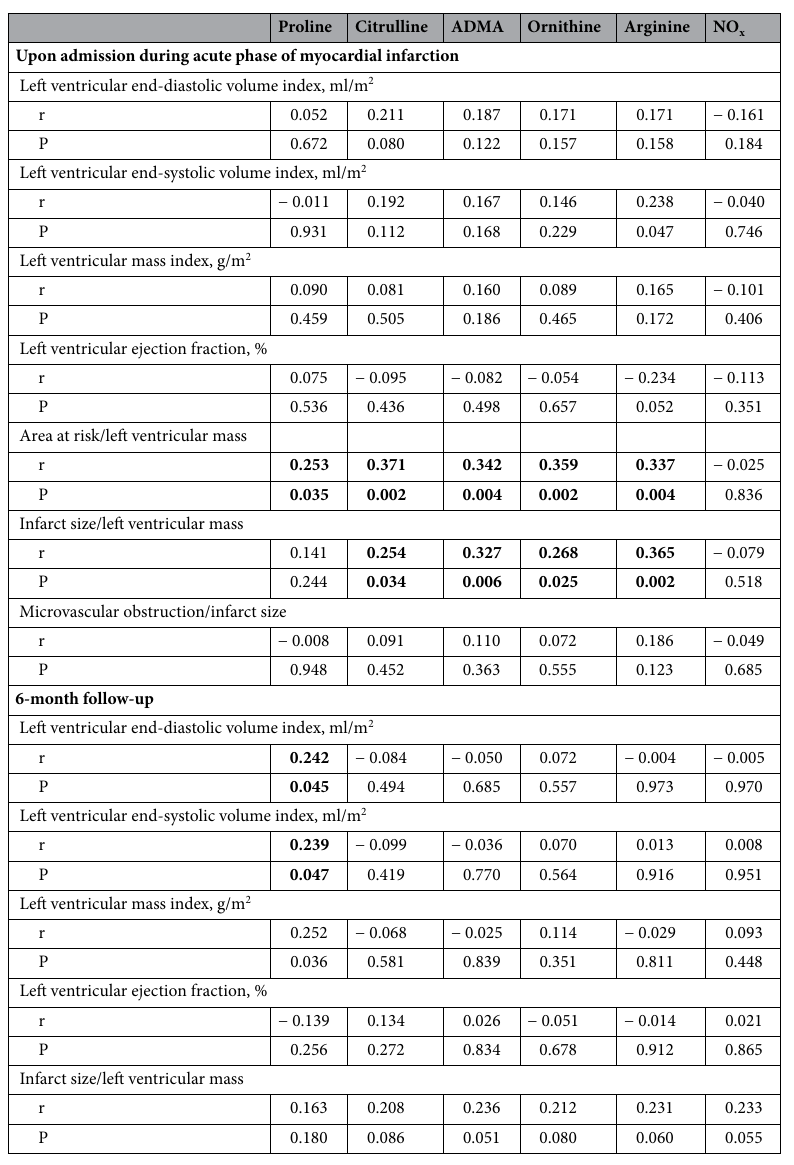
Table 4. Arginine metabolites versus cardiac magnetic resonance imaging findings. ADMA asymmetric dimethylarginine,